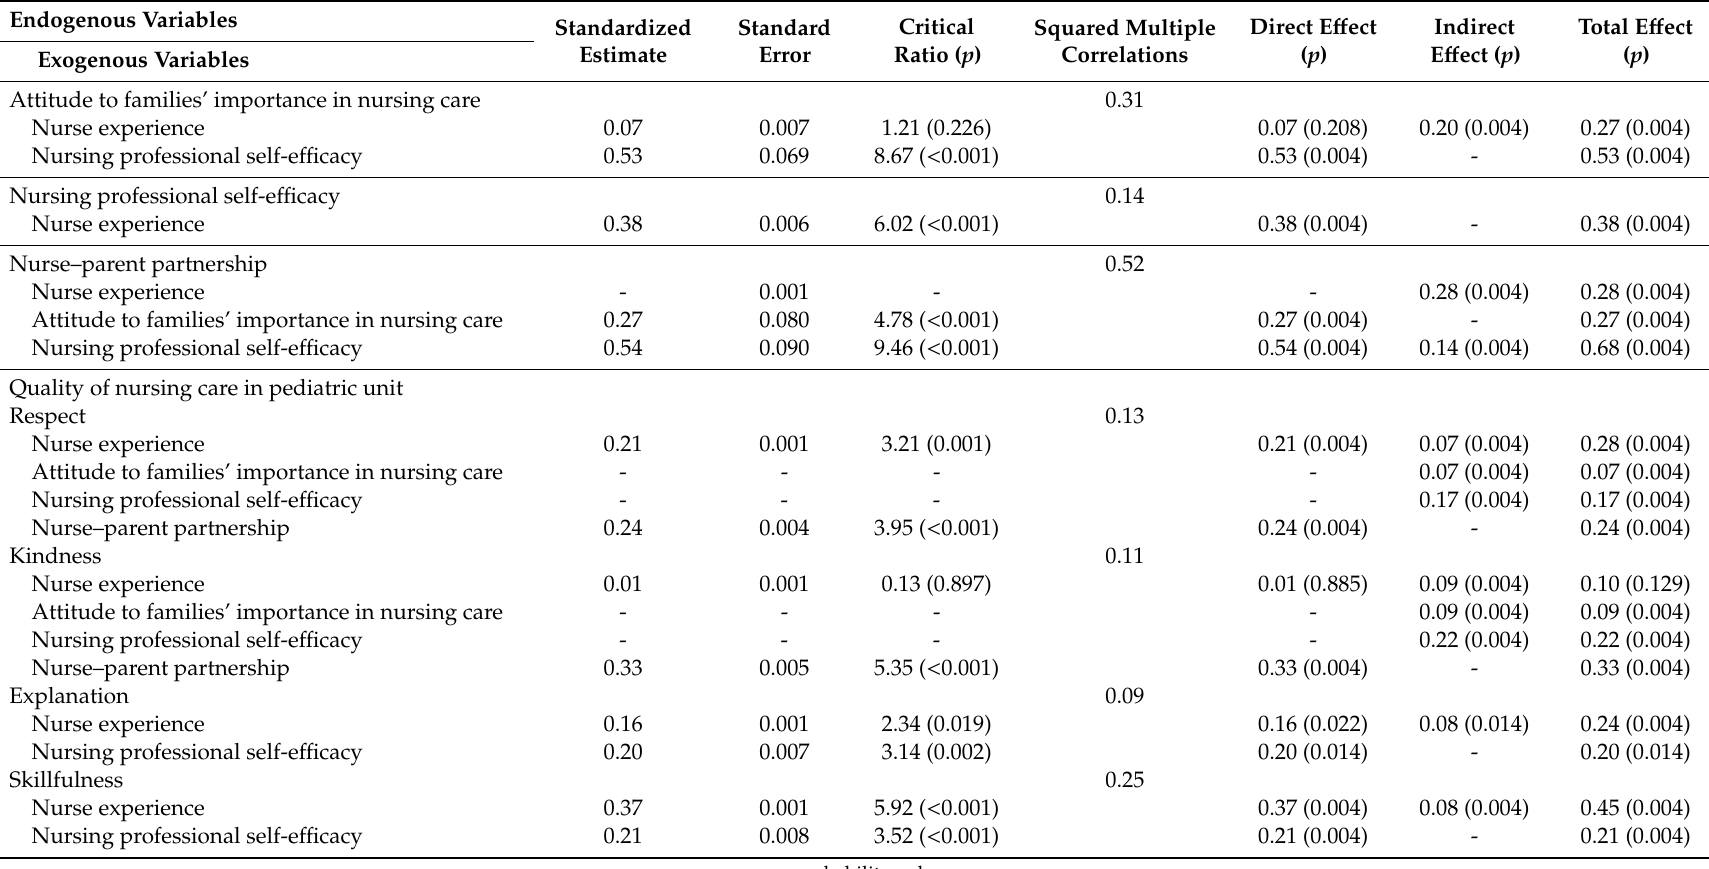
Table 3. Estimates and standardized e ff ect of the modified